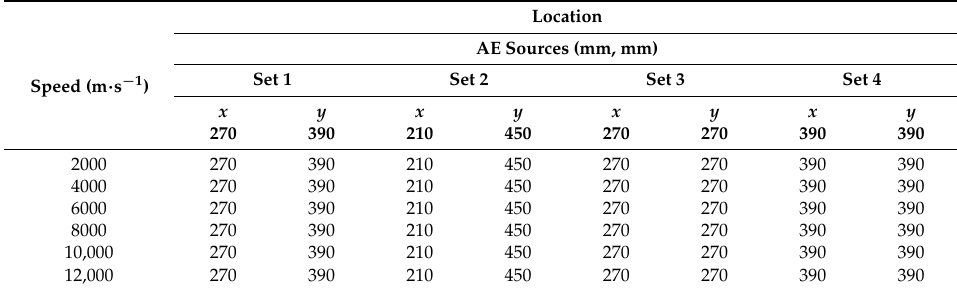
Table 1. Localization results of Bartlett beamforming under inaccurate wave speed.